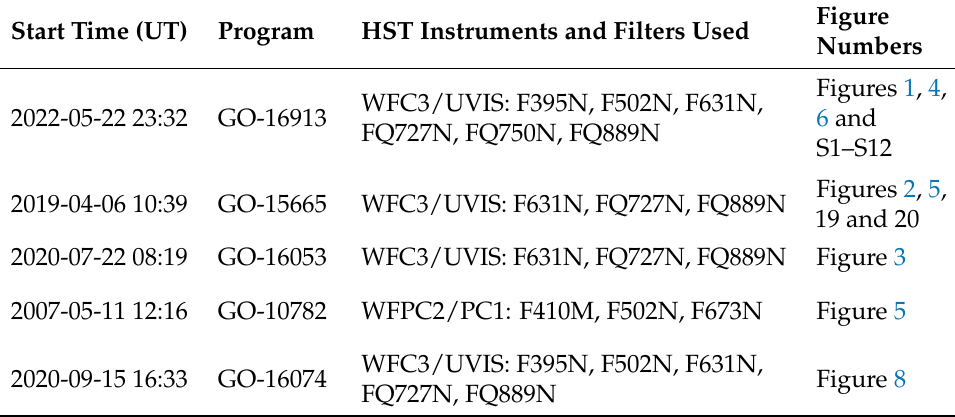
Figure 15. Both I/F and CM7 curves are shown together for a single model case ( τ haze = 3 and τ cloud = 100), to illustrate the optimal conditions for detecting variation due to the cloud pressure level. The model case is Jupiter-like because it has I / F values that fall within the observed maximum and minimum values as a function of µ 0 (dashed black lines). The low upper-layer opacity is key for sensing properties of the deeper layer, while the high deep-layer opacity maximizes the signal level in the 727-nm filter that provides depth sensitivity. Distinguishing between opacity at p cloud = 2 bar and p cloud > 2 bar is sufficient to rule out NH 4 SH composition for the deep cloud layer. This could be possible ( ∆ CM7 ∼ 0.4) in a situation where the upper cloud/haze opacity are well constrained. Table 1. HST Jupiter observations used in this